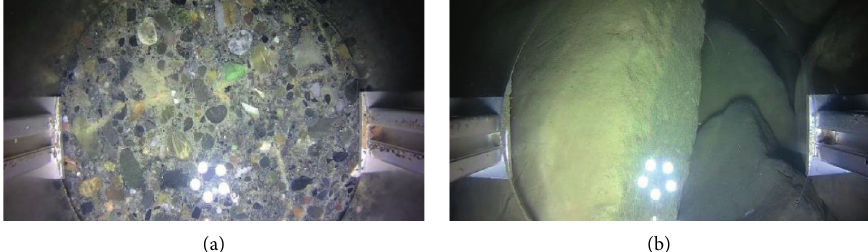
Figure 14: HD underwater pictures of the stilling basins. (a) Surface outlet stilling basin (no sediment). (b) Bottom outlet stilling basin (obvious